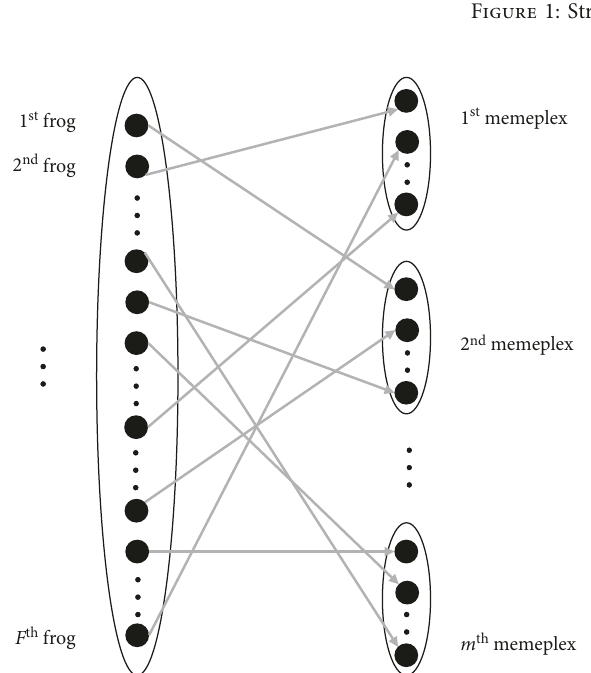
Figure 2: Schematic illustration of memeplex partitioning process